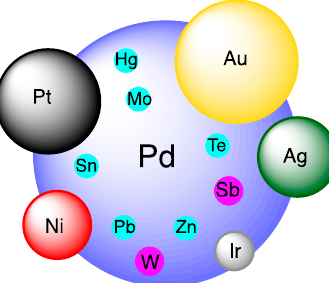
Figure 3. A schematic representation of the different alloying metals/promoters used to improve Pd performance. Areas approximately correspond to their occurrence in the literature.